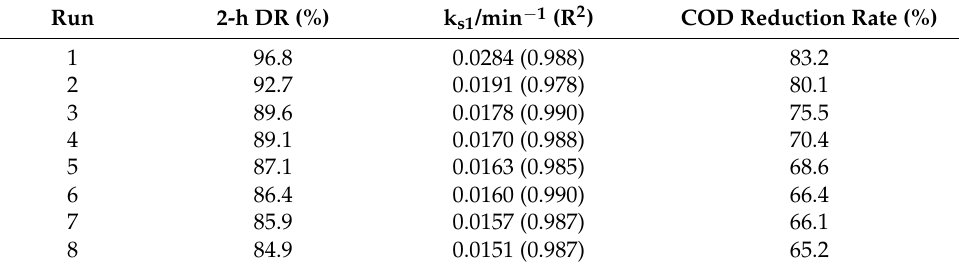
Table 3. Recyclability of F-Fe 3 O 4 -1 for catalytic degradation of OG with H 2 O 2 1